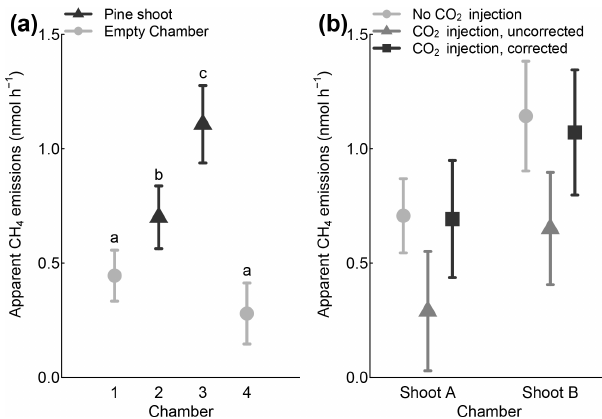
Figure 7. Observed apparent CH 4 fluxes in two empty shoot cham- bers and two shoot chambers with pine shoots (a) . Furthermore, comparison of CH 4 fluxes during chamber closures without and with CO 2 injections (b) . Only daytime (illuminated) measurements are included in the figure. Error bars indicate 95% confidence inter- vals.